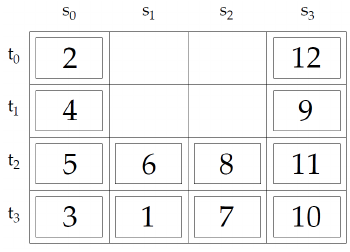
Figure 3. The example of CRP with yard bay with 4 tiers and 4 stacks. The stacks are indexed from left to right with number values from 0 to 3, similarly with the height of the stacks, i.e., tiers. The uppermost tier has index 0 (tier t (cid:2868) ), and the lowermost tier has index 3 (tier t (cid:2871) ). The position of the containers is determined by an ordered pair (t, s). For example, container 4 is located at position (1, 0). Each container has a priority retrieving number according to which it is shipped from the bay. The smaller the number, the sooner the container is shipped from the bay. The goal is to retrieve all containers from the bay with the minimum number of reshuffles (relocations of blocking containers) [17]. Only containers blocking the container currently being retrieved can be relocated to another stack. Containers can be relocated to a particular stack only if the stack is not fully occupied (the number of containers in the stack is 4). As mentioned earlier, we propose a new method based on a genetic algorithm to minimize the number of relocations within the bay. The genetic algorithm finds an optimal sequence of positions for relocating blocking containers. The process of determining an optimal sequence of container relocations using a genetic algorithm is described in detail below. 4.2.1. The Chromosome Before starting the genetic algorithm, the chromosome that represents the solution to the optimization problem must be defined. In our procedure for solving CRP, the chromosome consists of a sequence of integer numerical values (genes) whose values depend on the total number of stacks. Each numerical value represents the position (stack) to which the next blocking container must be relocated. Thus, the values of the genes within the chromosome are equal to the indices of the stacks. The example of a chromosome solving the CRP on a bay with four tiers and four stacks (Figure 3) can be seen in Figure 4.